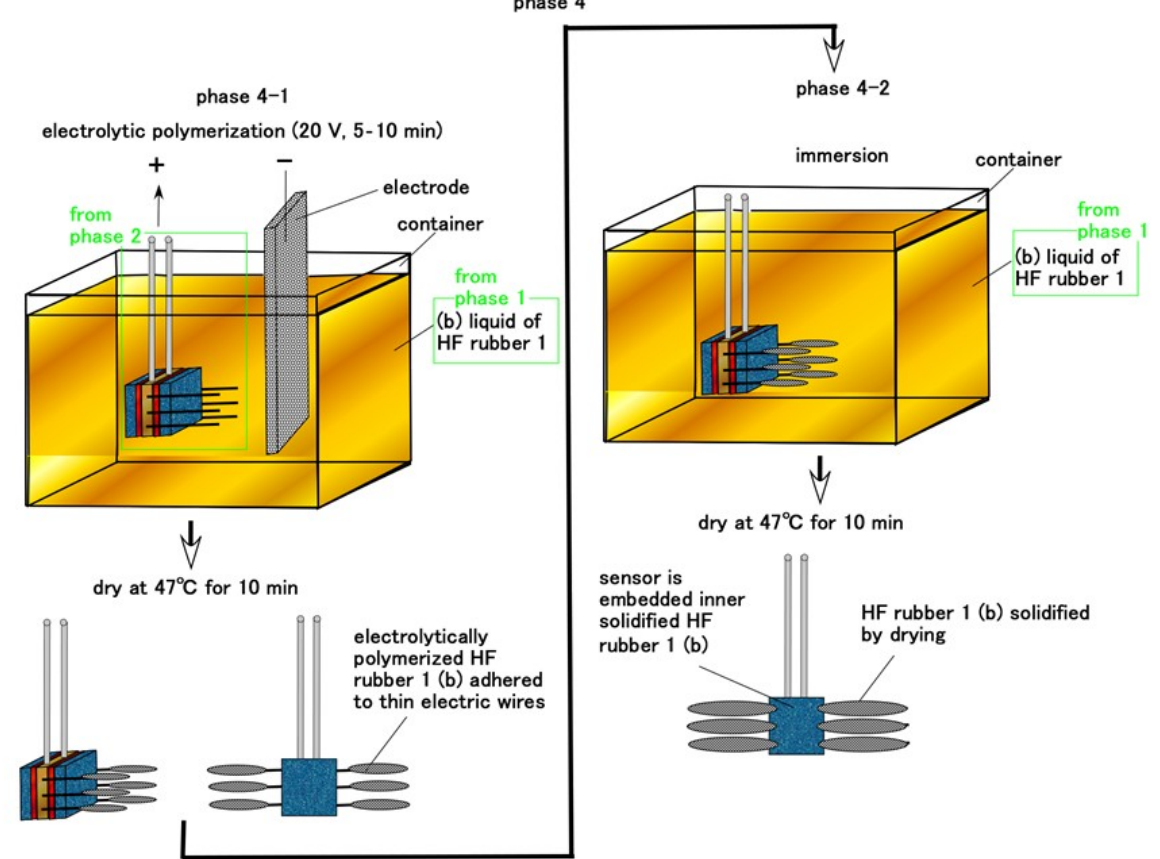
Figure 6. Schematic of the fabrication of free nerve endings and Krause endbulbs as cutaneous receptors during Phase 4. For Meissner corpuscles, the HF sensor consummated during Phase 3 is embedded in the inner part of B HF rubber liquid 1 in Phase 1 and electrolytically polymerized during Phase 5, as shown in Figure 7. Such as in Figure 6, the many thin electric wires are attached by vulcanized HF rubber liquid b. The coiled HF rubber sensor is then embedded in B HF rubber liquid 1 in Phase 1 again and dried; B HF rubber liquid 1 solidifies around the coiled HF rubber sensor.